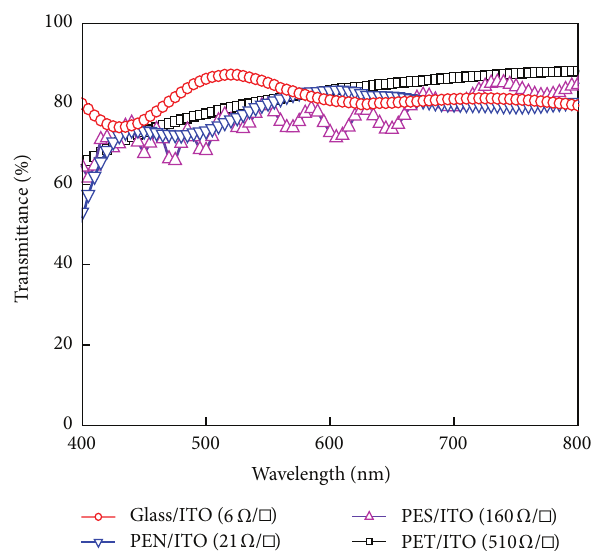
Figure 2: Optical transmittance of four different ITO substrates used in this work. The sheet resistance of each substrate is given in the legend.